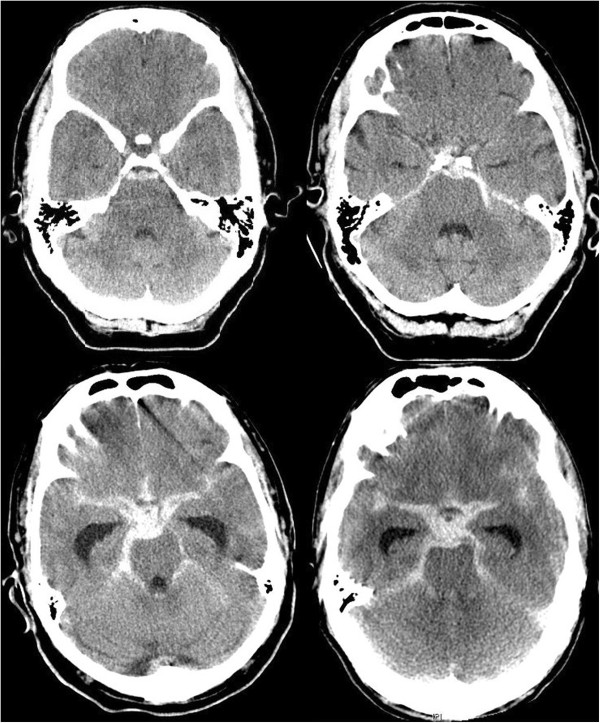
Perimesencephalic and non-perimesencephalic SAH. In the upper row CT scans of two patients with perimesencephalic SAH are illustrated. Whereas in the top left-hand the center of the hemorrhage is located anterior the brainstem, in the top right-hand corner the hemorrhage is located more left-sided. In the lower row CT scans of two patients with non-perimesencephalic SAH are illustrated. In both patients the bleedings are not only located anterior the midbrain, but also enlarging into the sylvian and interhemispheric cisterns. Also in contrast to the upper row these patients had a hydrocephalus with enlargement of the temporal horns.